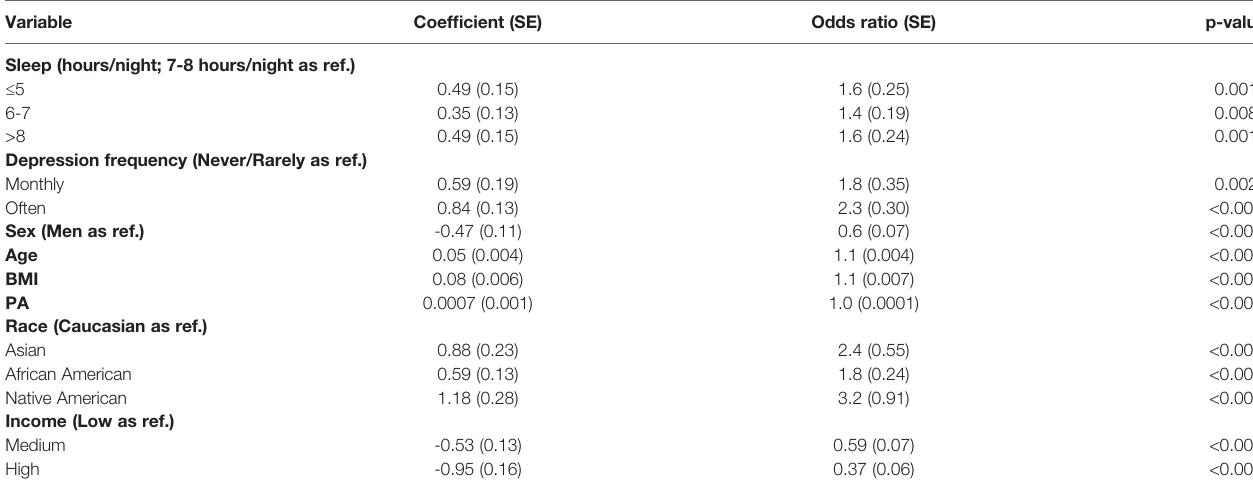
TABLE 2 | Multivariate logistic regression. Variable Coef fi cient